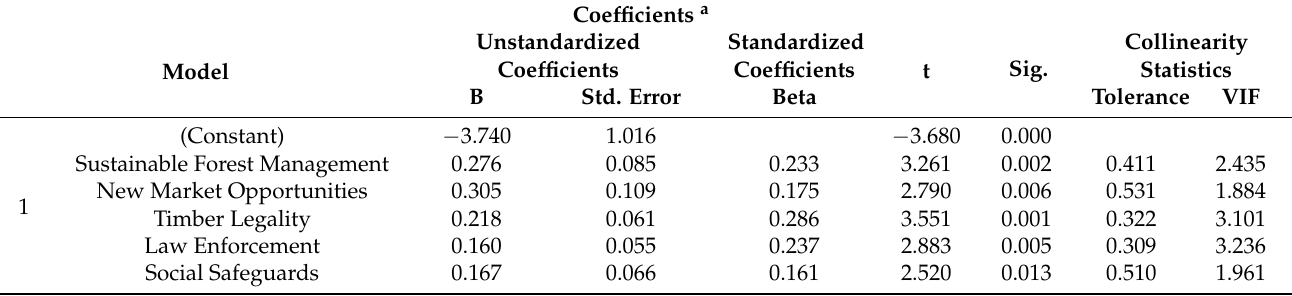
Table A2. Multicollinearity Test results.